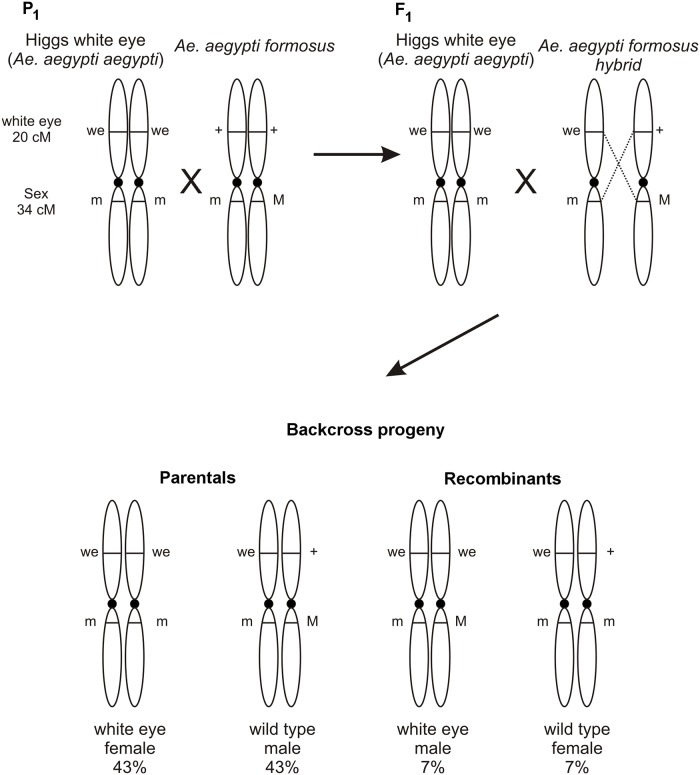
Crossing scheme used to assess the recombination rate between the white-eye (20 cM) and SDL (34 cM) markers on chromosome 1.The two loci were expected to have a recombination rate of 0.14. Male (M) alleles are dominant in Aedes so that males are M/m heterozygotes and females are m/m homozygous recessive. Wild type males +/+; M/m from a population of interest were crossed to a virgin HWE female (we/we; m/m) to produce F1 individuals heterozygous for the white-eye locus and the SDL. Male F1 were we/+; M/m which were backcrossed to virgin HWE females. Subsequent backcross progeny were scored for sex and eye color. Of the four possible phenotypes, white-eye females and wild-type males are parental genotypes, and white-eye males and wild type females are recombinant genotypes.